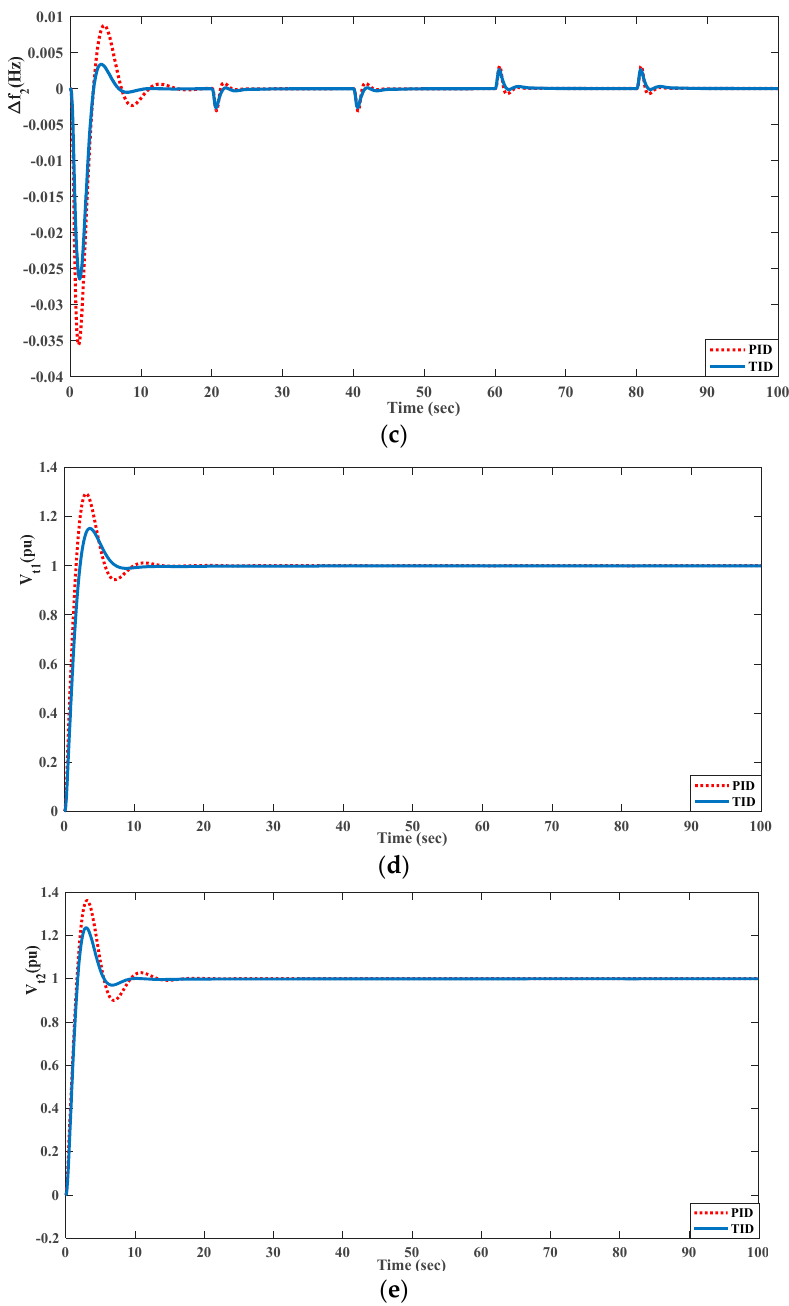
Figure 21. System dynamics for the combined AGC and AVR system with RLP. ( a ) Δ f 1 ; ( b ) Δ P tie ; ( c ) Δ f 2 ; ( d ) V t1 ; ( e ) V t2 .